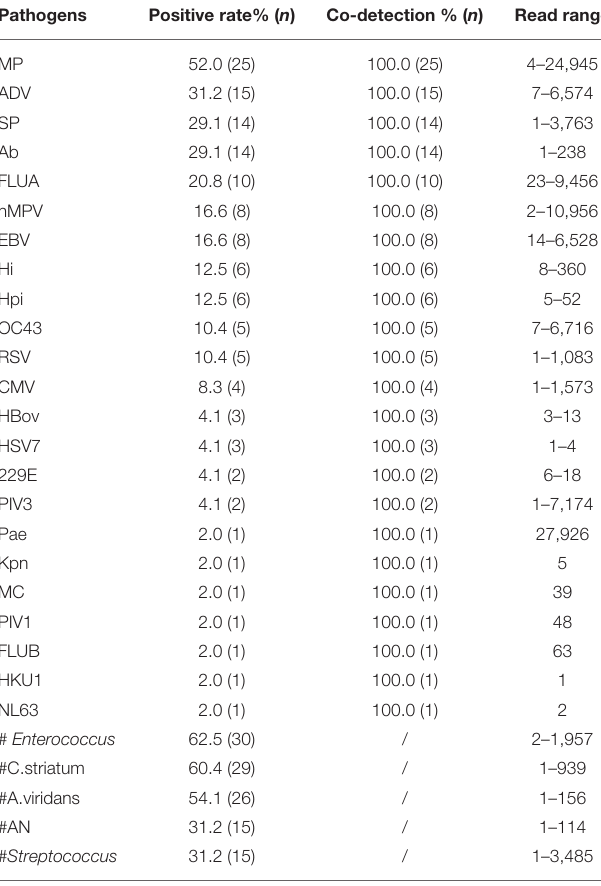
TABLE 4 | TAS pathogens detection judged by ID Reading in 48